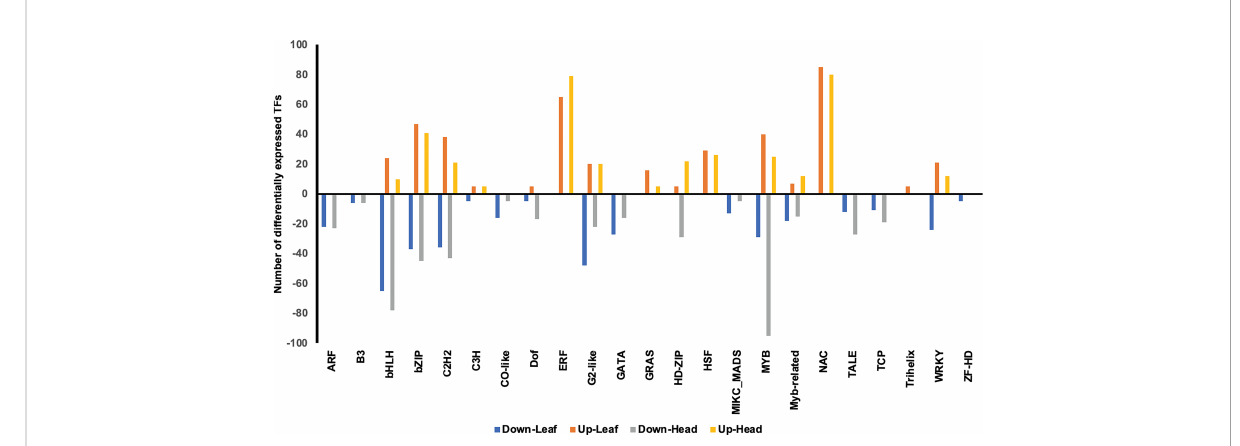
FIGURE 12 Transcription factors (TF) in leaf and head tissues that are differentially expressed in response to heat, drought and combined stress in Golden Promise and Otis. Only families of TFs with >5 expressed members are